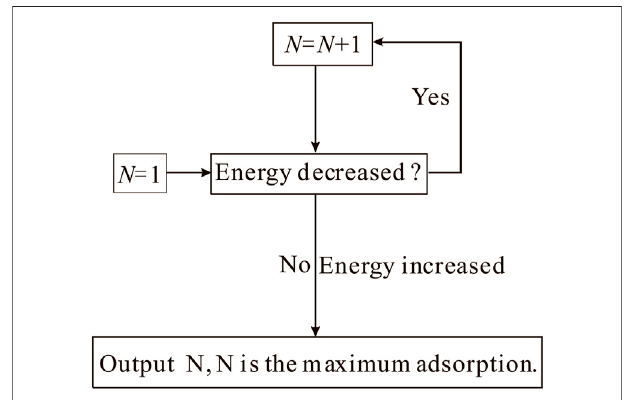
FIGURE 4 | Adsorption process fl ow chart for MD and GCMC (Song et al., 2017b).